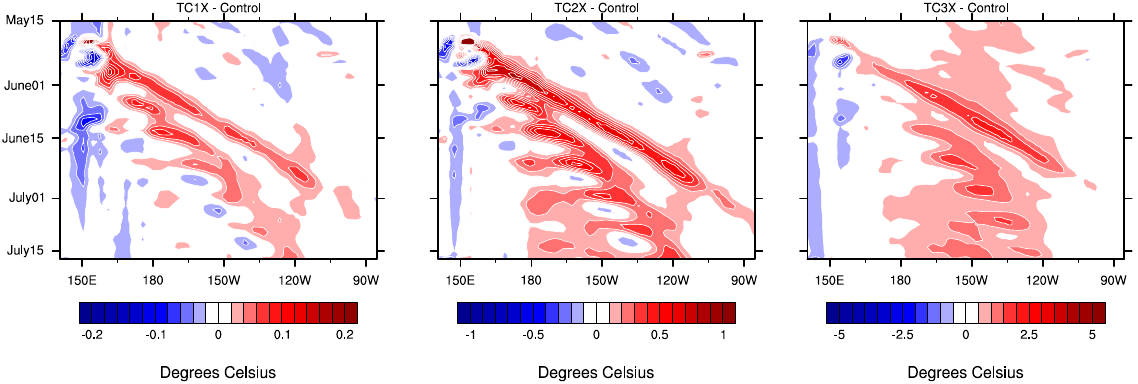
Fig. 7. Longitude-time plots of modeled daily temperature anomalies averaged between 0 and +5 ◦ N and 100–200m depth for CCSM simulations with different scaling factors applied to the TC wind speed estimates derived from QuikScat: (A) 1X, (B) 2X, and (C) 3X. Anomalies in all plots are calculated relative to the control simulation and the mean difference has been removed as in Fig. 3a. Note the general wave characteristics are consistent between cases, but the magnitude of the temperature response increases with TC wind